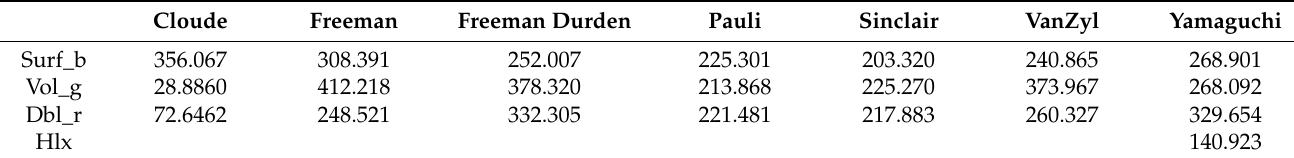
Table 4. The SNR values of the feature components (dB).